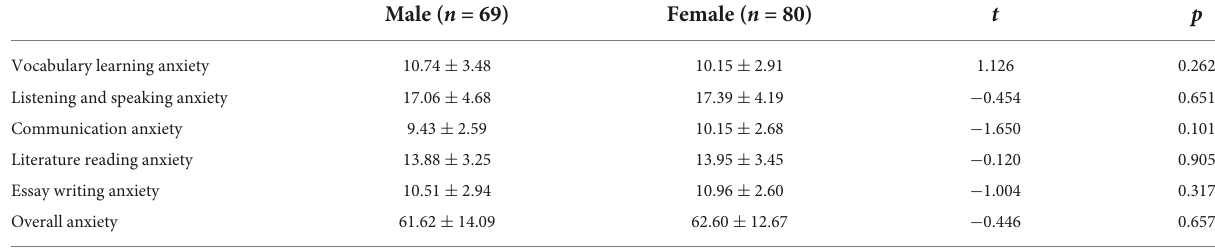
TABLE 6 Gender difference test of medical students’ English learning anxiety.